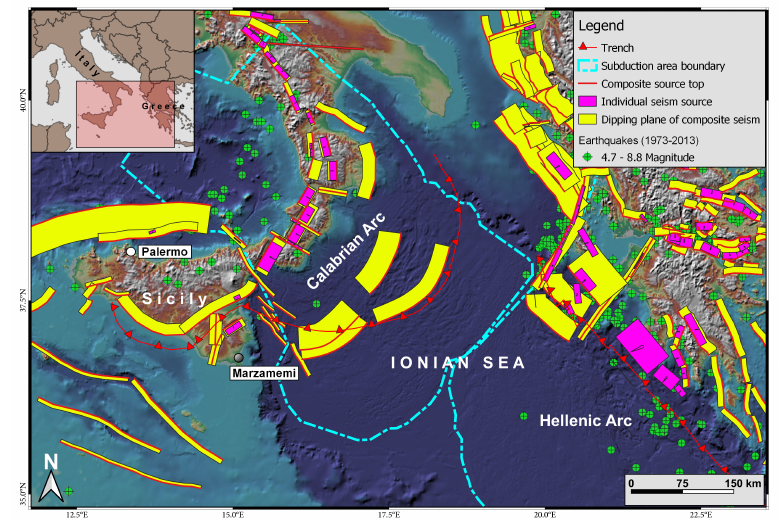
Figure 1. Possible seismic sources in the Ionian Sea. The data-set is taken from the DISS Working Group [20], Caputo and Pavlides